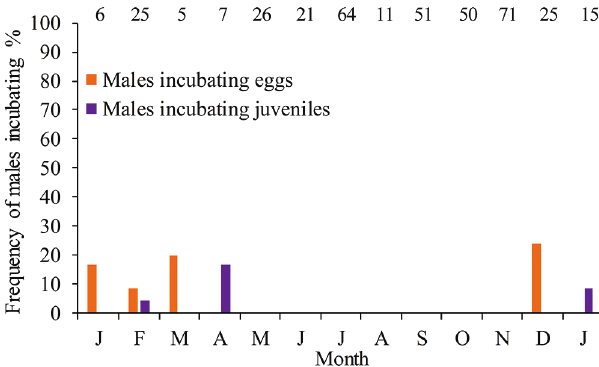
Fig. 4. Monthly distribution of the relative frequency (%) of Genidens genidens males (N = 377) performing oral incuba- tion of eggs and juveniles in Guanabara Bay, Rio de Janeiro, Brazil from January 2014 to January 2015. The values at the top indicate the total number of adult males caught each